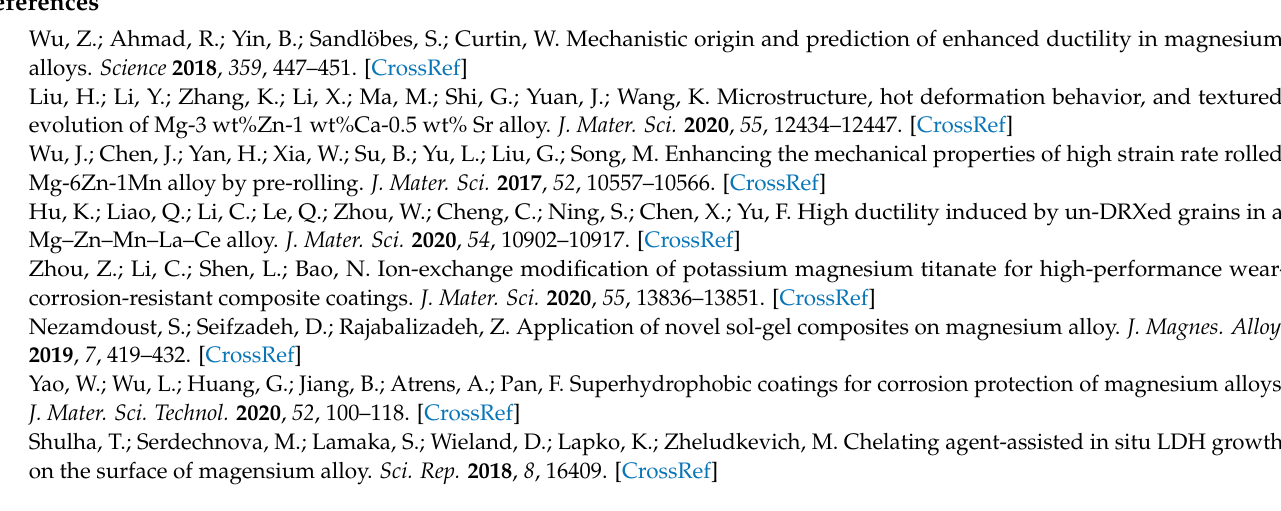
Figure S2: SEM images and EDS results of LDHs films on Mg alloy after the immersion test for 7 days. Figure S3: Optical images of samples after the immersion